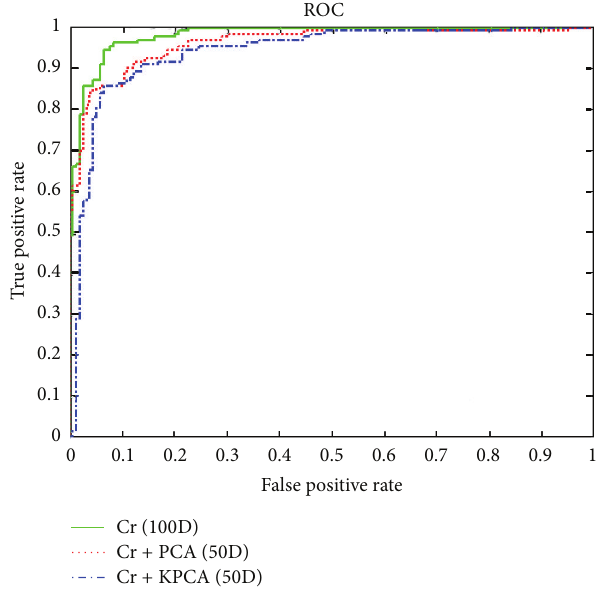
Figure 7: Comparison between gray-scale images in 100D, with PCA in 50D and kernel PCA in